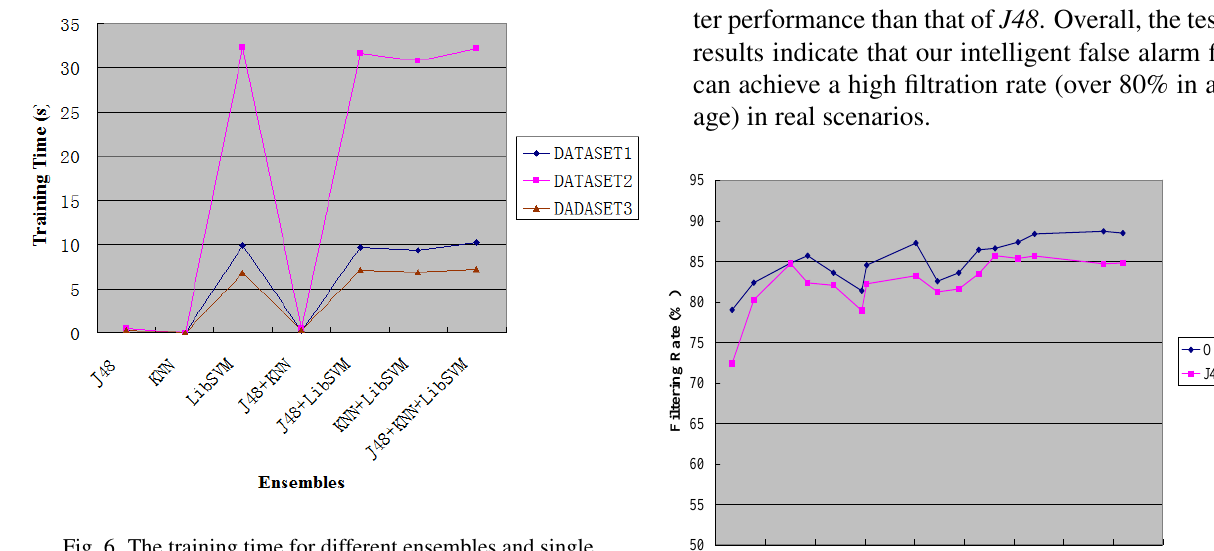
Fig. 6. The training time for different ensembles and single algorithms.